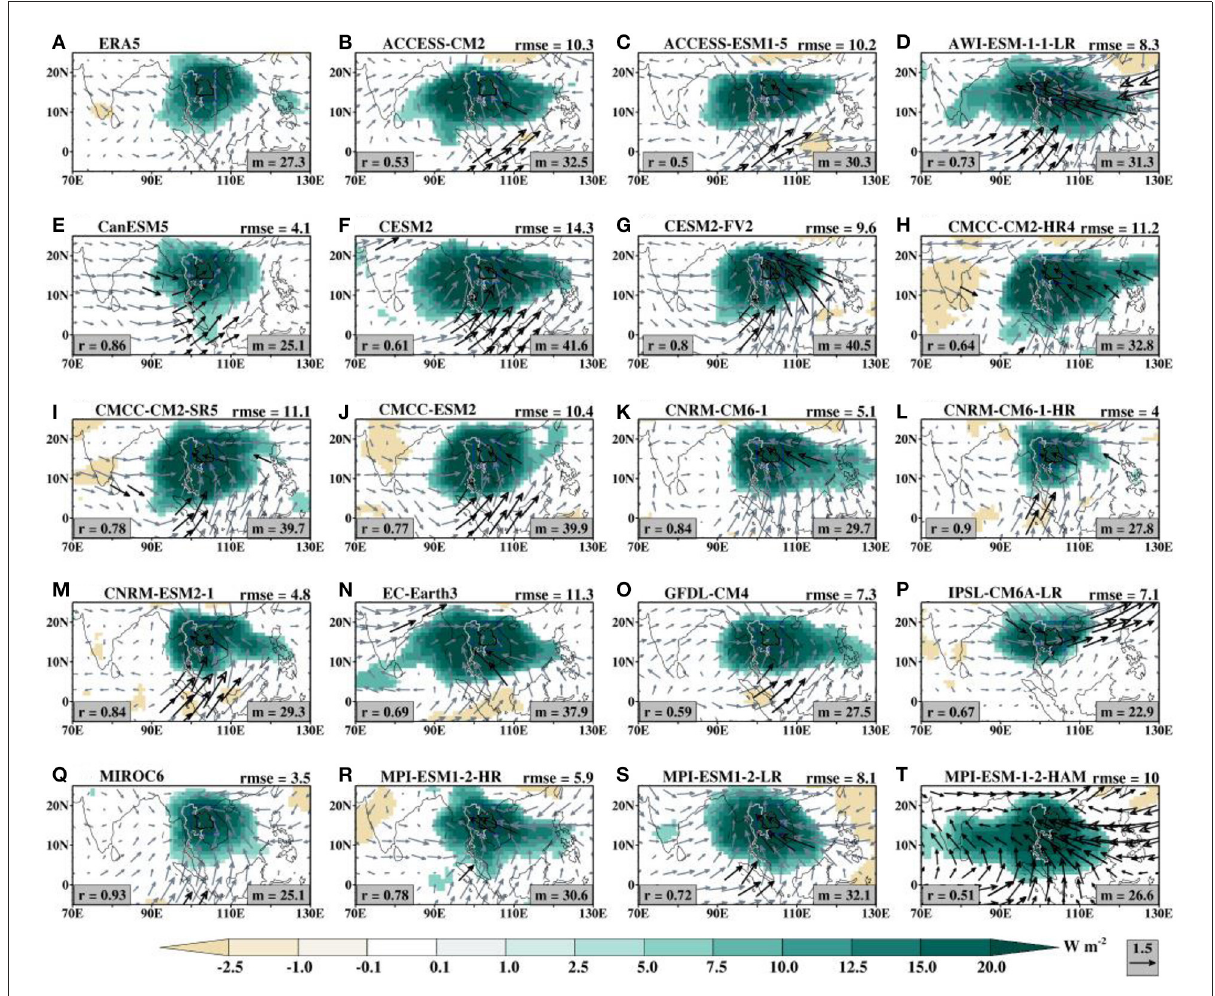
FIGURE4 As in Figure 2, but for (A) ERA5 and (B–T) simulated OLR (shaded) and associated wind fields at 250mb